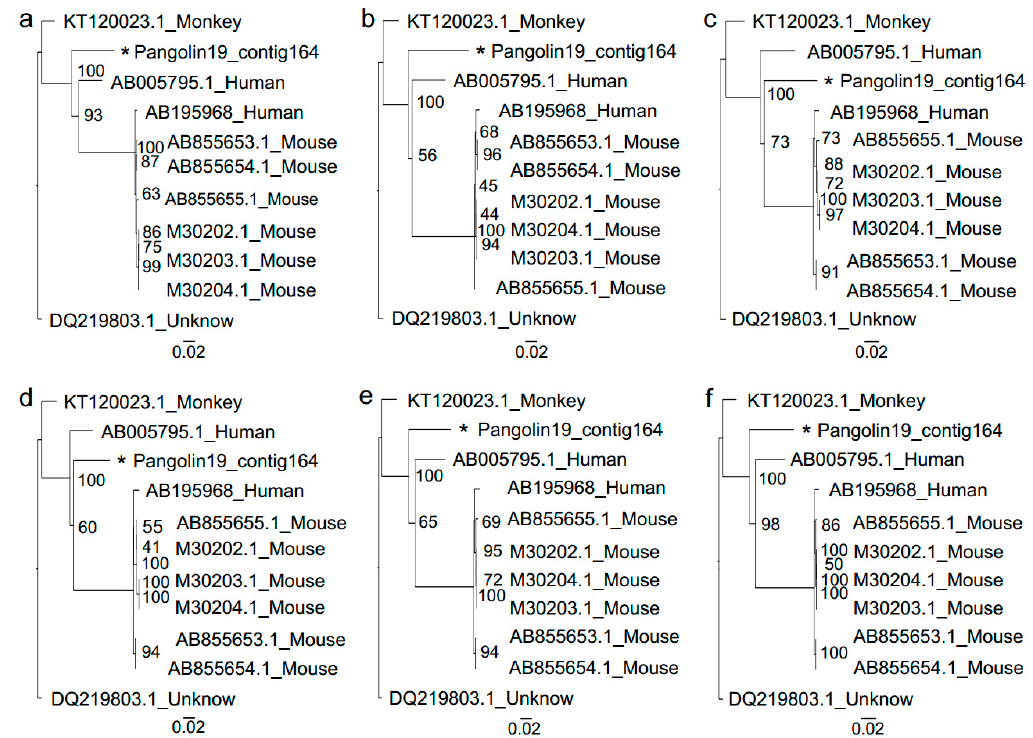
Figure 4. The phylogenetic tree of each gene of the Sendai virus from Malayan pangolin and other hosts. The analysis was inferred using the Maximum Likelihood method based on iqtree [24]. Branch bootstrap values are shown and were based on 1000 replicates. The black star indicates a contig of the Sendai virus from M. javanica in 2019.